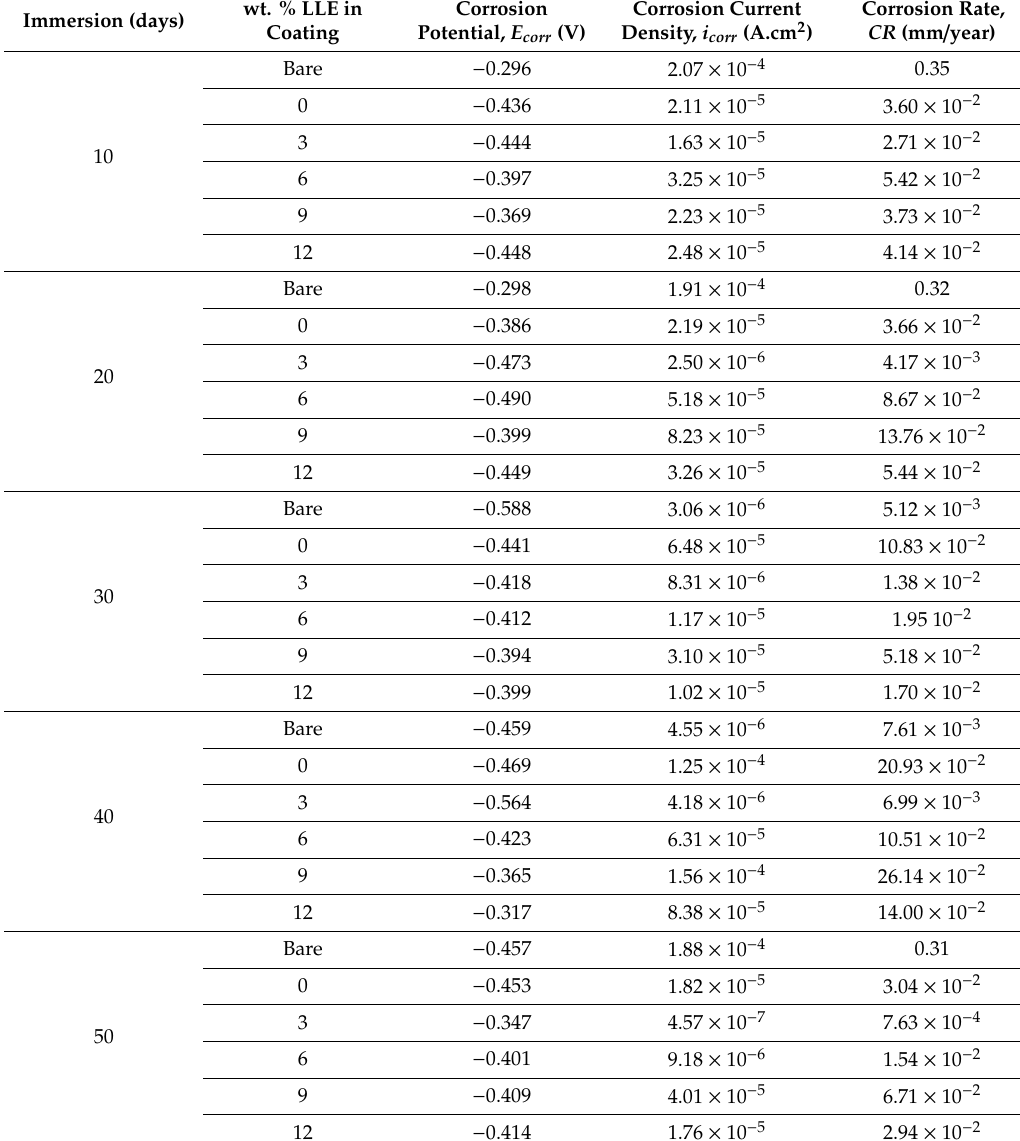
Table 8. Polarization